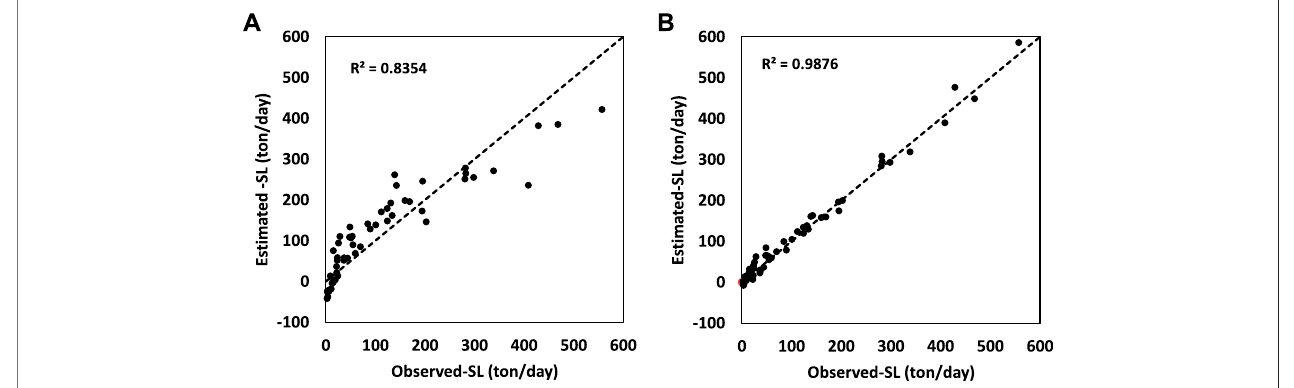
FIGURE 8 | Results for ANFIS and ANFIS – ACOr in all inputs. (A) SL predicted by ANFIS in the test mode. (B) SL predicted by ANFIS – ACOr in test mode.